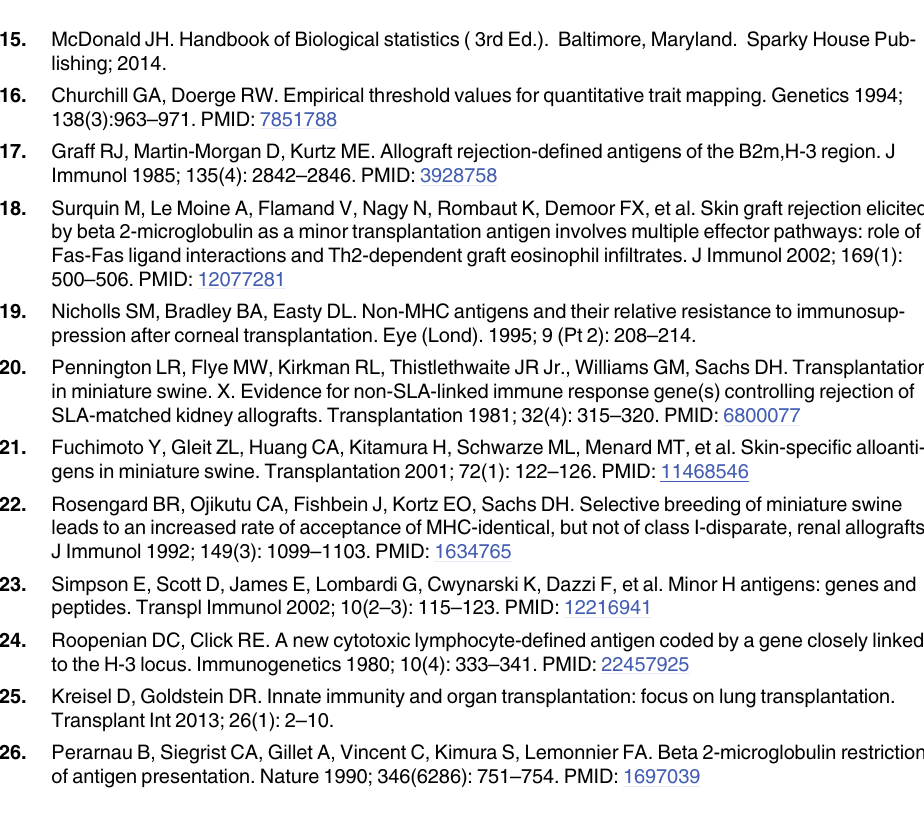
PLOS ONE | DOI:10.1371/journal.pone.0152155 March 24,